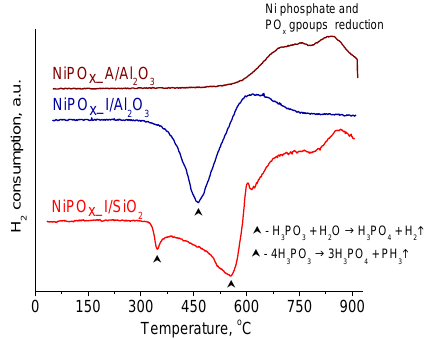
Figure 1. H 2 -TPR profiles of NiPO x _A/Al 2 O 3 , NiPO x _I/Al 2 O 3 and NiPO x _I/SiO 2 precursors.